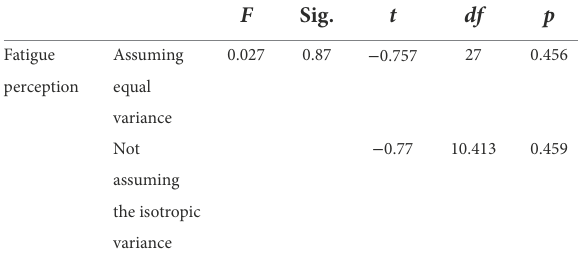
TABLE 12 Independent samples t -test between experimental and control groups on fatigue perception. F Sig. t